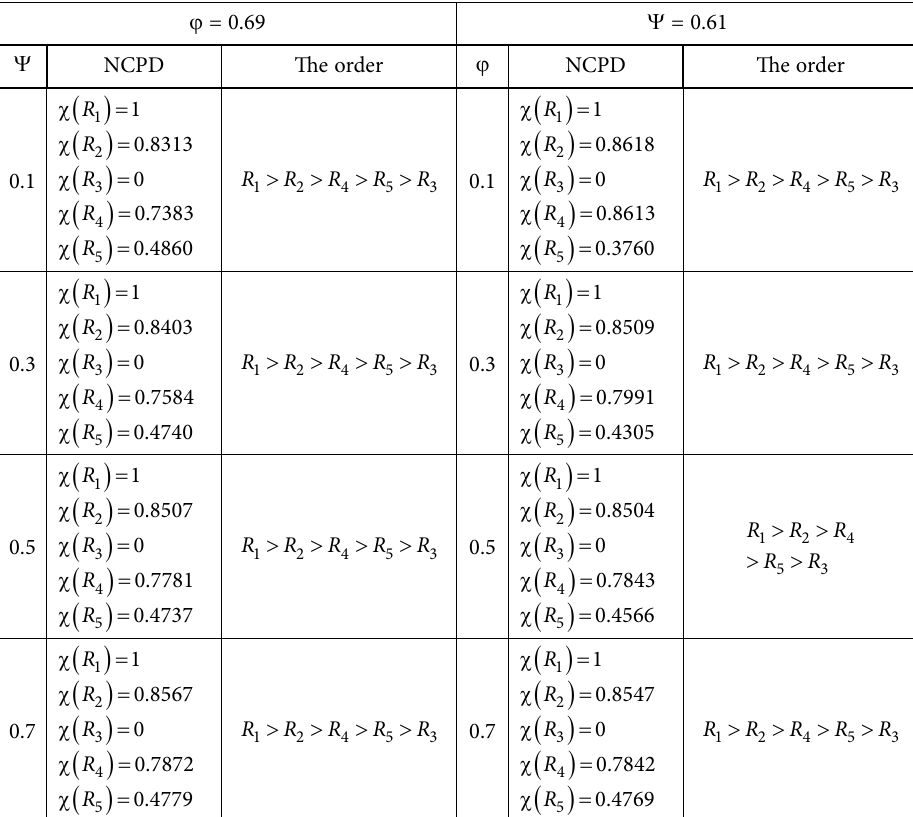
Table 7. The outcomes of parameters Y and j varying separately j = 0.69 Y = 0.61 Y NCPD The order j NCPD The